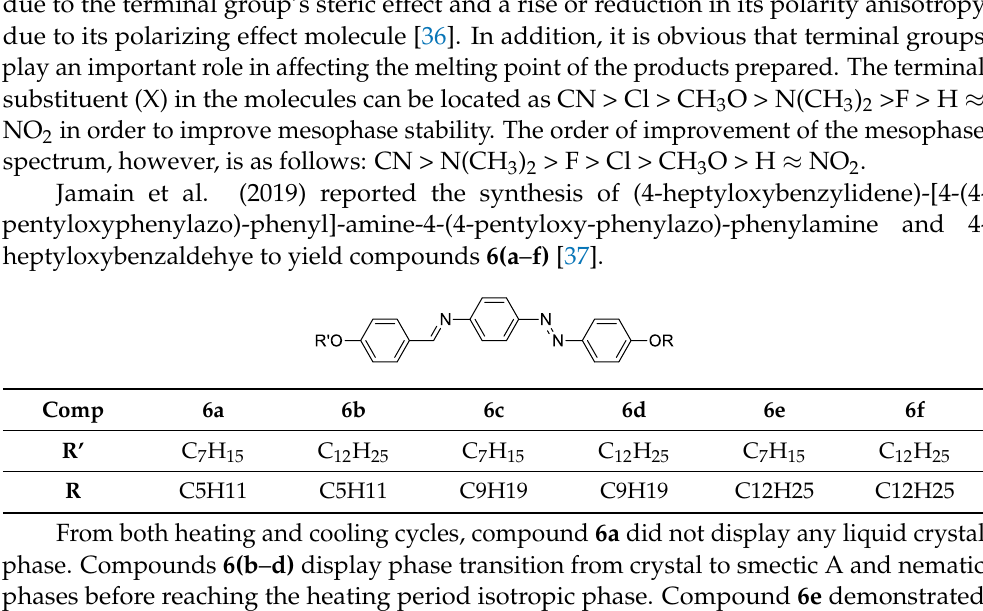
Figure 7. The optical photomicrograph of ( a ) nematic phase of compound 5b at 99.0 °C upon cooling; ( b ) Smectic A phase of compound 5f at 106.0 °C. Reprinted/adapted with permission from Ref. [28]; published by Elsevier, 2020.